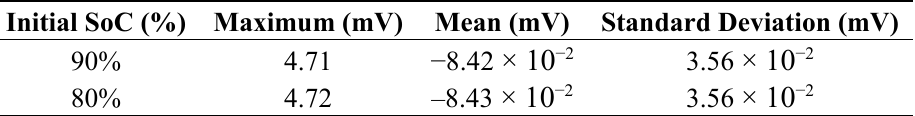
Table 3. Statistical results of the voltage prediction error.